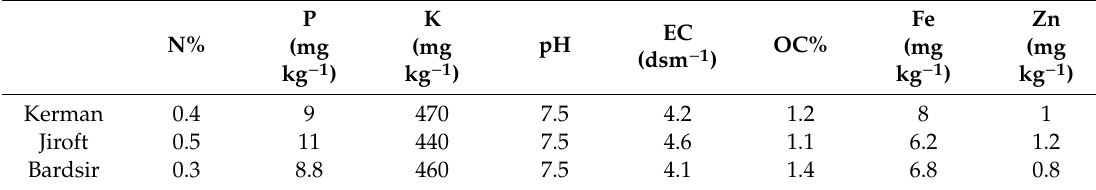
Table 2. Soil properties of the study sites in Kerman, Jiroft, and Bardsir during the growing season.